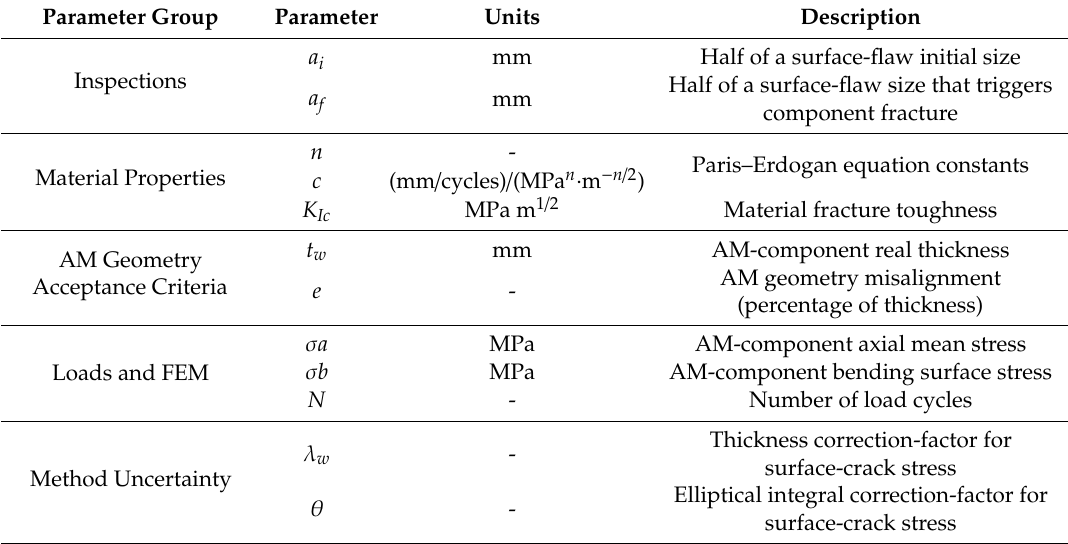
Table 1. Additive manufacturing